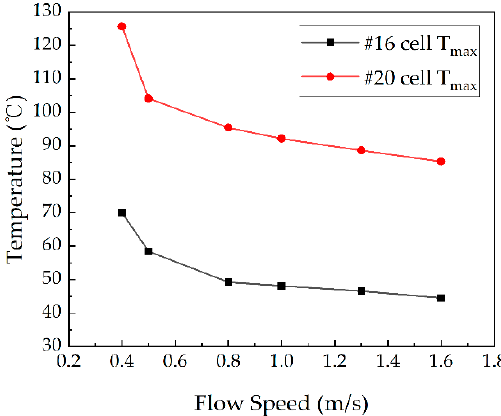
Figure 13. Variations in the maximum temperature of the ba tt ery at di ff erent fl ow rates. (For #20 in the corner.) the